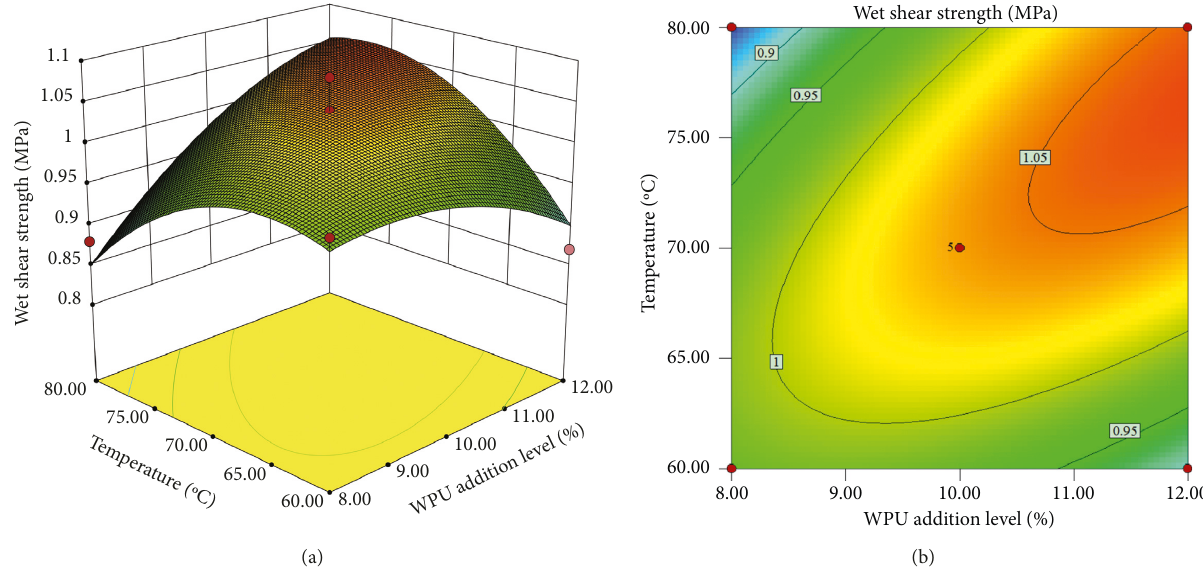
Figure 5: Response surface and contour plots for effect of temperature and WPU addition level on wet shear strength.